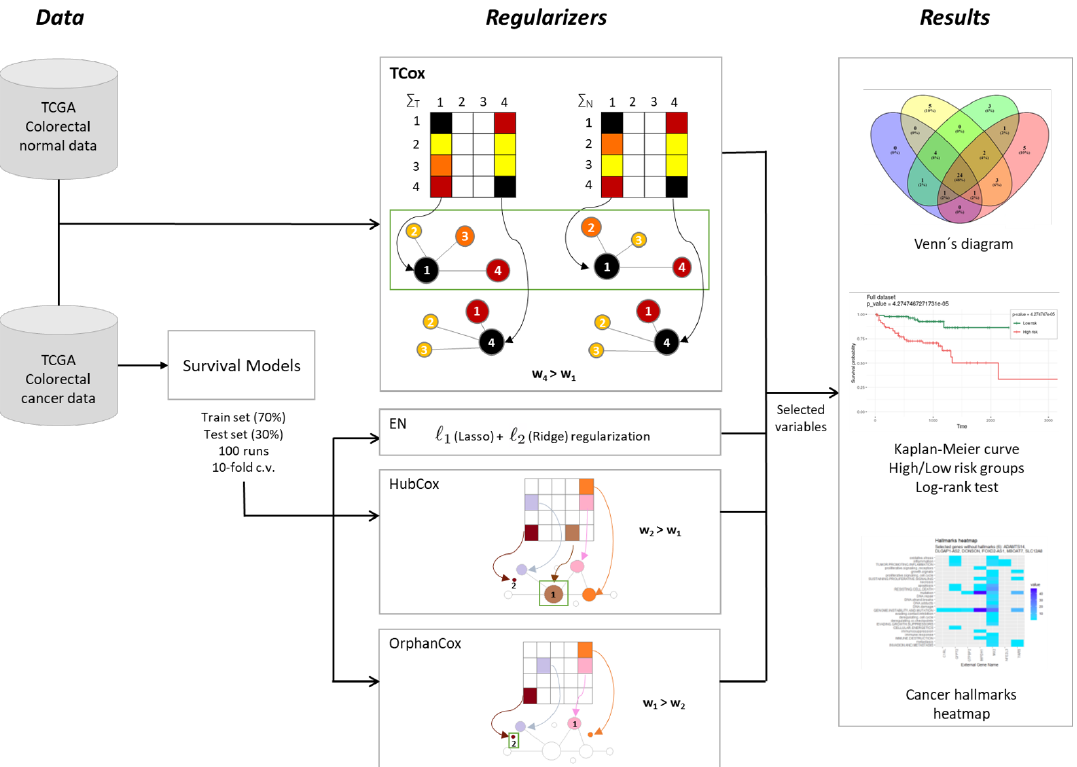
Figure 1. Methodological procedure for the identification of gene signatures in colorectal cancer